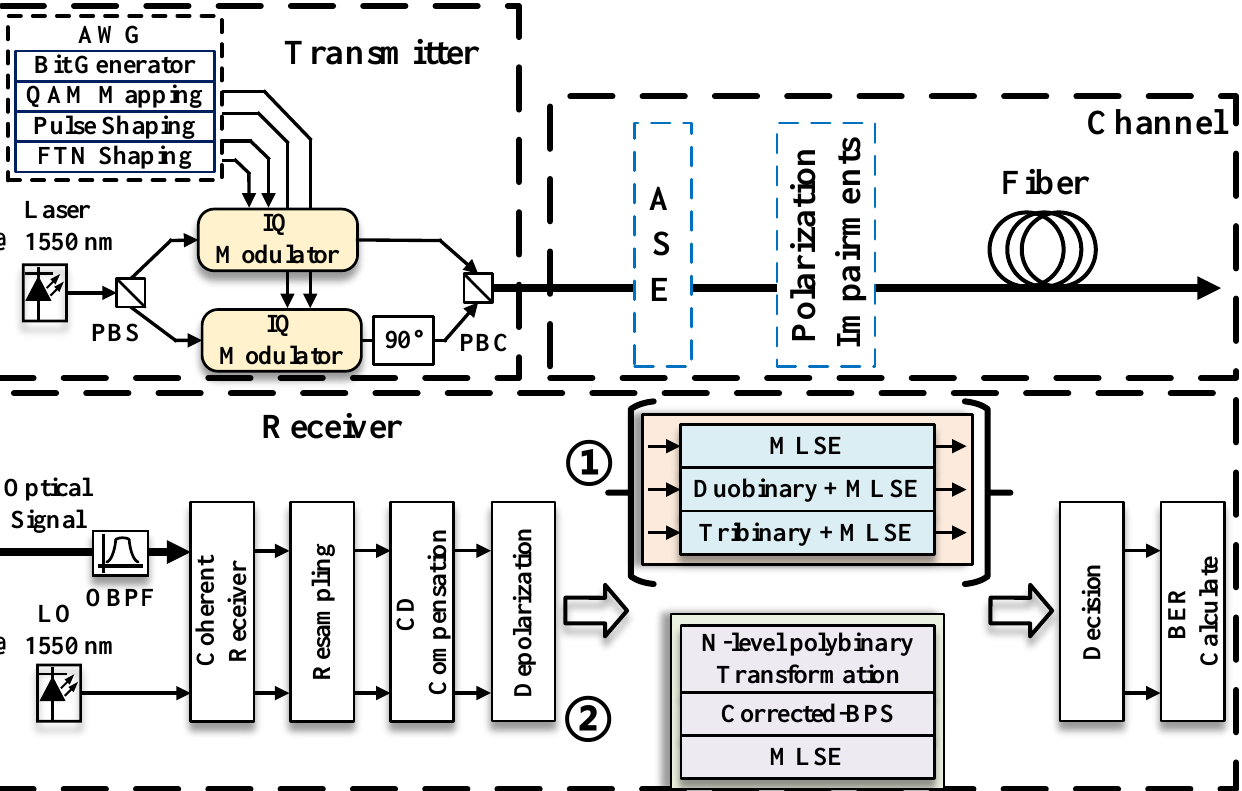
Figure 5. Simulation platform for 28GBaud PDM-FTN-QPSK system.